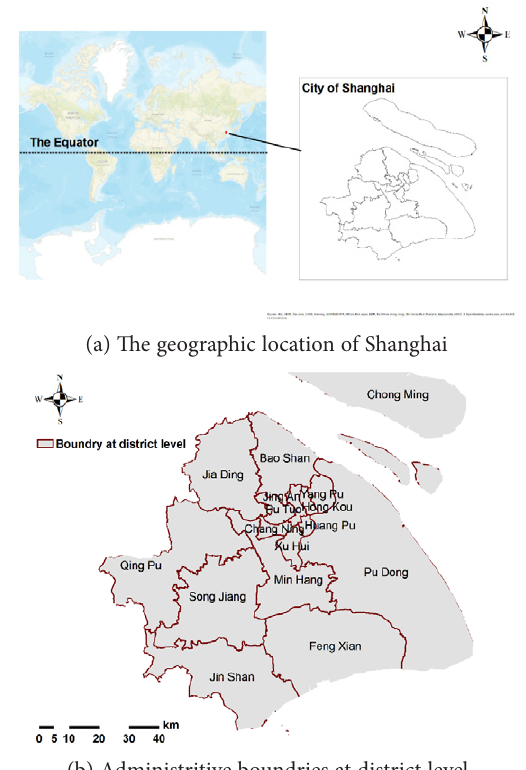
Figure 1. Panel (a) shows the city of Shanghai is located in the northern hemisphere, and thus sunlight comes from the south. Panel (b) shows the administrative boundary at district level